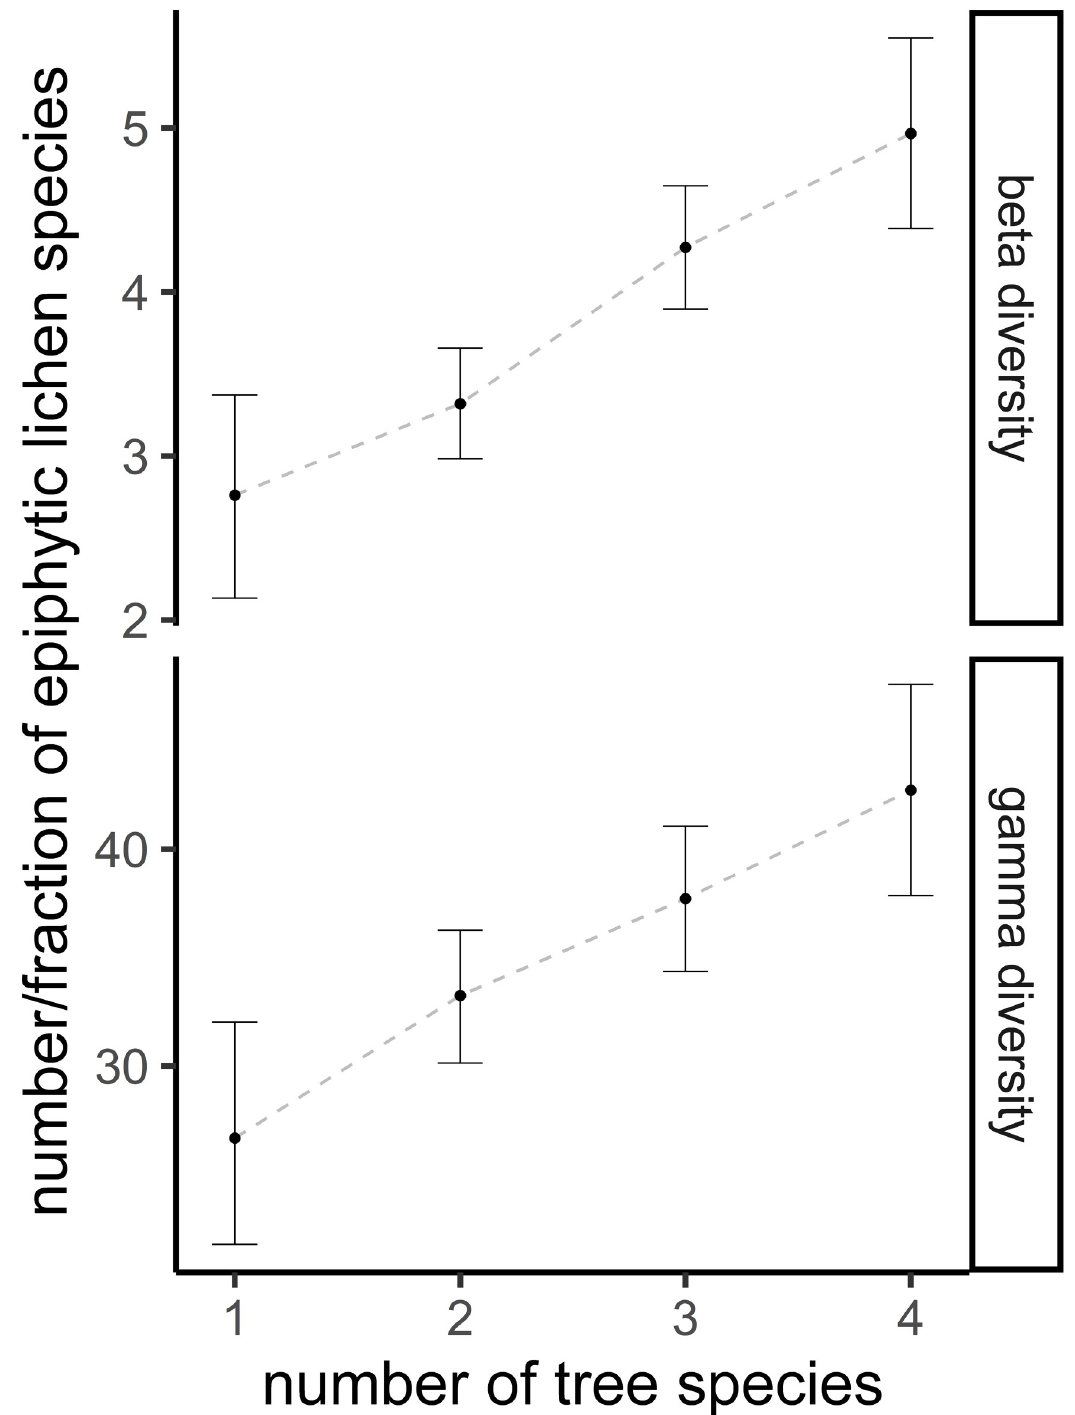
Fig 2. Stand level beta and gamma diversity is modelled with the number of tree species in a subplot. The predictions are the median together with the 95% credible intervals. Higher tree species richness was in all pairwise comparisons associated with higher lichen diversity with a posterior probability of 95%. The data on which this figure is based can be downloaded from https://doi.org/ 10.5281/zenodo.3899847. The data was originally created by Klein & Thor [39] and reused but not modified under the CC BY 4.0 license by